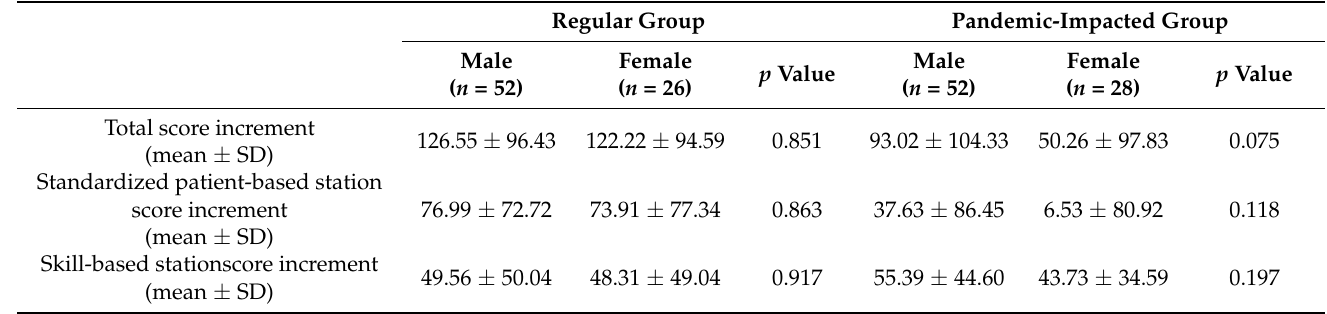
Table 2. Score increment between first mock OSCE and national OSCE.